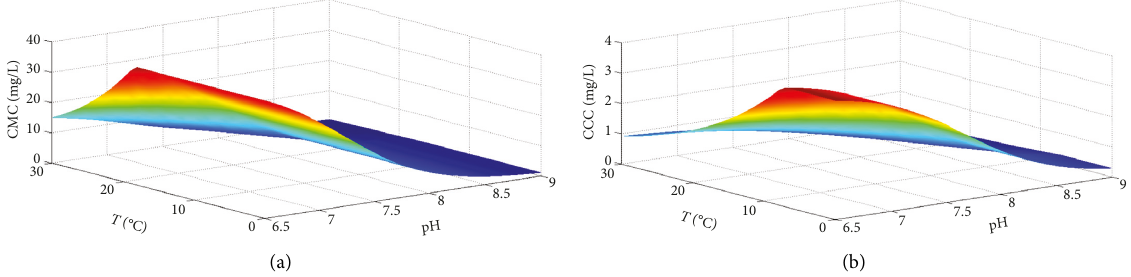
Figure 4: Chinese ammonia nitrogen water quality criteria vary with water temperature and pH. (a) CMC. (b) CCC. Table 1: Sites with ammonia nitrogen ecological risk in summer and autumn of